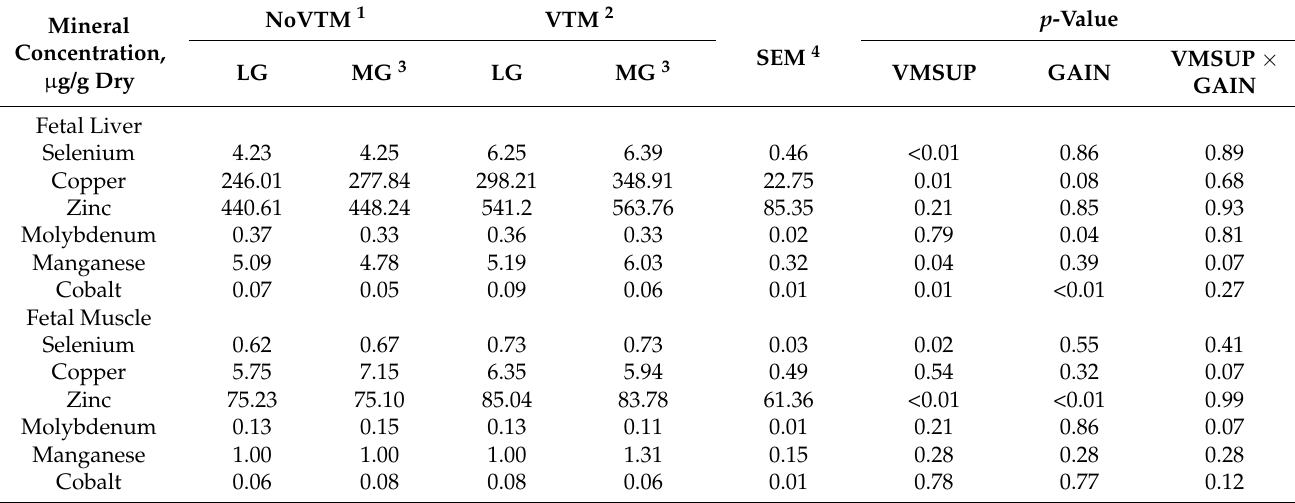
Table 5. Concentrations of trace minerals in fetal liver and fetal muscle at d 83 of gestation as influenced by maternal vitamin and mineral supplementation (VMSUP) and two different rates